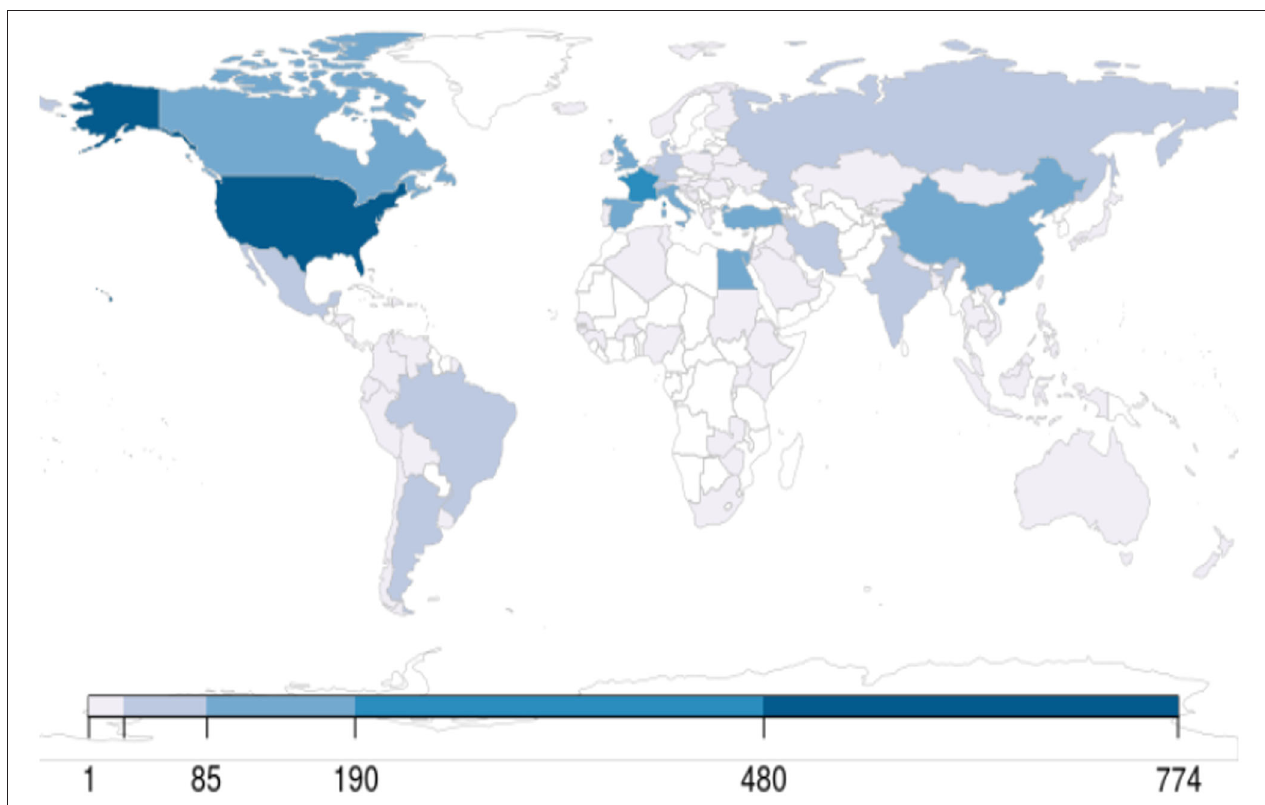
FIGURE 2 | World map showing the distribution of clinical trials, counted per the primary institution listed on ClinicalTrials.gov as of October 31,